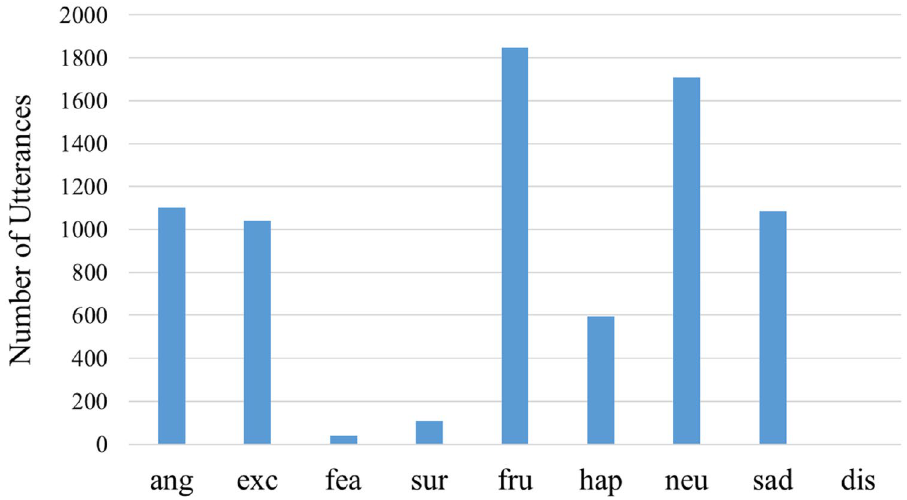
Figure 2. The number of utterances for each emotion category. Note : The number of utterances classified in “disgusted” was 2. Additionally, ang = angry; exc = excited; fea = fearful; sur = surprised; fru = frustrated; hap = happy; neu = neutral; sad = sad; dis =